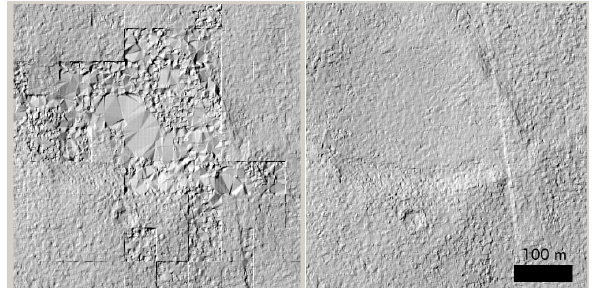
Figure 10. Detail of shaded relief map of a DTM made from ESP 035895 1965 and ESP 036172 1965, which had mean jitter magnitudes of 0.8717 and 0.41184 px, respectively. Left) Shaded relief image of the DTM made with non-jitter corrected images. Artifacts are failures of the stereo correlator due to excessive mismatch between images. Right) The same area of the DTM produced from jitter corrected images. The “seam” between detectors is quantitatively reduced but does not disappear. Examining elevation profiles across the seam confirms that the offset is